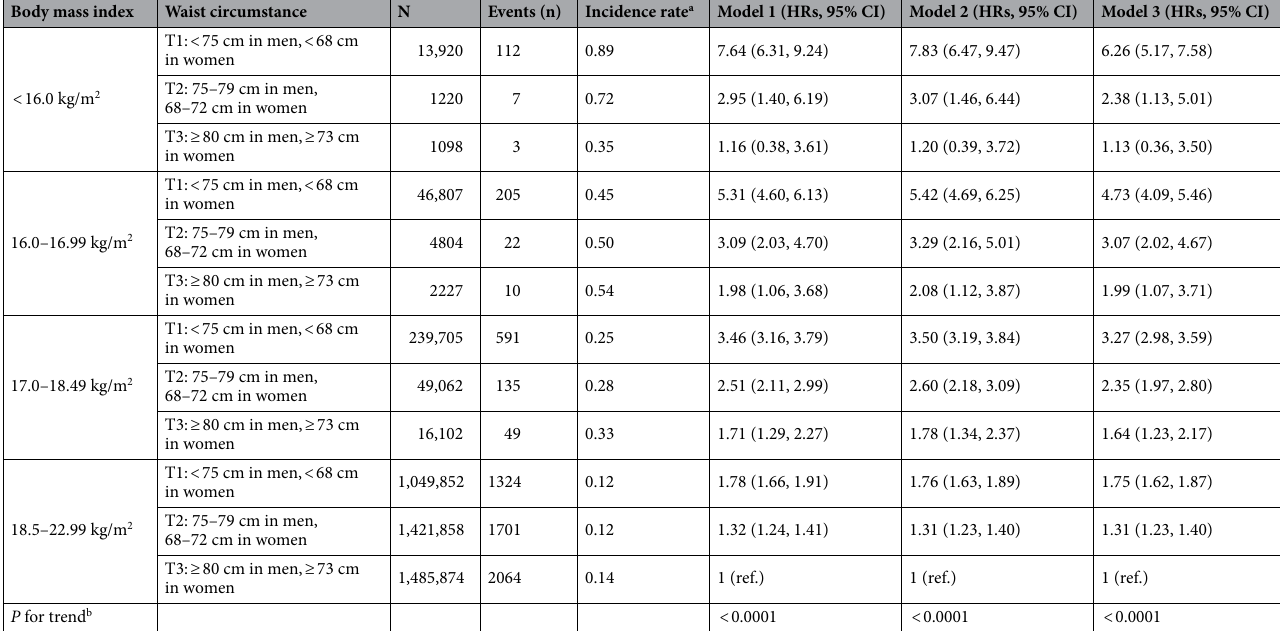
Table 3. Risk of non-tuberculosis mycobacterial pulmonary disease according to waist circumferences (WC) and severity of underweight. Model 1, adjusted for age and sex; Model 2, model 1+ smoking, alcohol intake, and regular exercise; Model 3, model 2+ respiratory diseases, solid cancer, hematologic malignancy, transplantation, AIDS, GERD, connective tissue diseases, diabetes mellitus. HRs hazards ratios, 95% CI 95% confidence interval. a Per 1000 person-years. b P -values for the trend were < 0.0001 for all variables because of the large size of the study population.